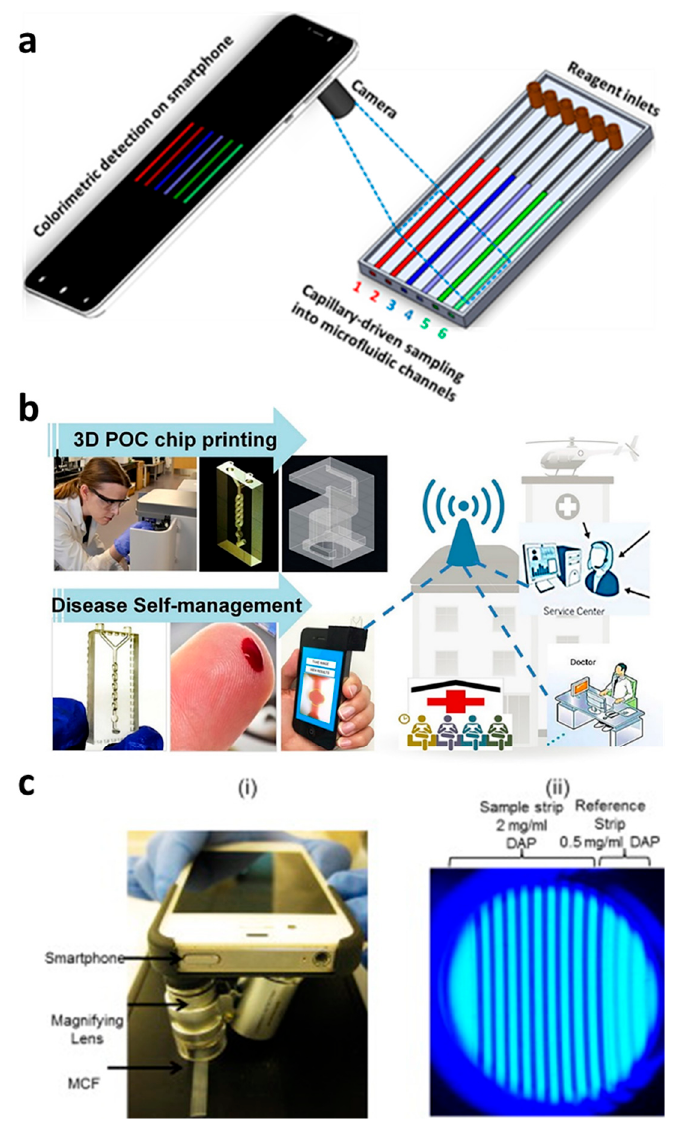
Figure 4. Smartphone-based capillary-driven flow microfluidics. ( a ) The transient filling of a microchannel at six different time points obtained using the CFD model; ( b ) smartphone-based detection system for anemia detection in microchannels via capillary flow. Reproduced with permission from [83]; ( c ) Smartphone-based fluoropolymer microcapillary detection system ( i ) and an image of fluoropolymer microcapillaries (FEP) filled with 2,3-diaminophenazine ( ii ). Reproduced with permission from [43].